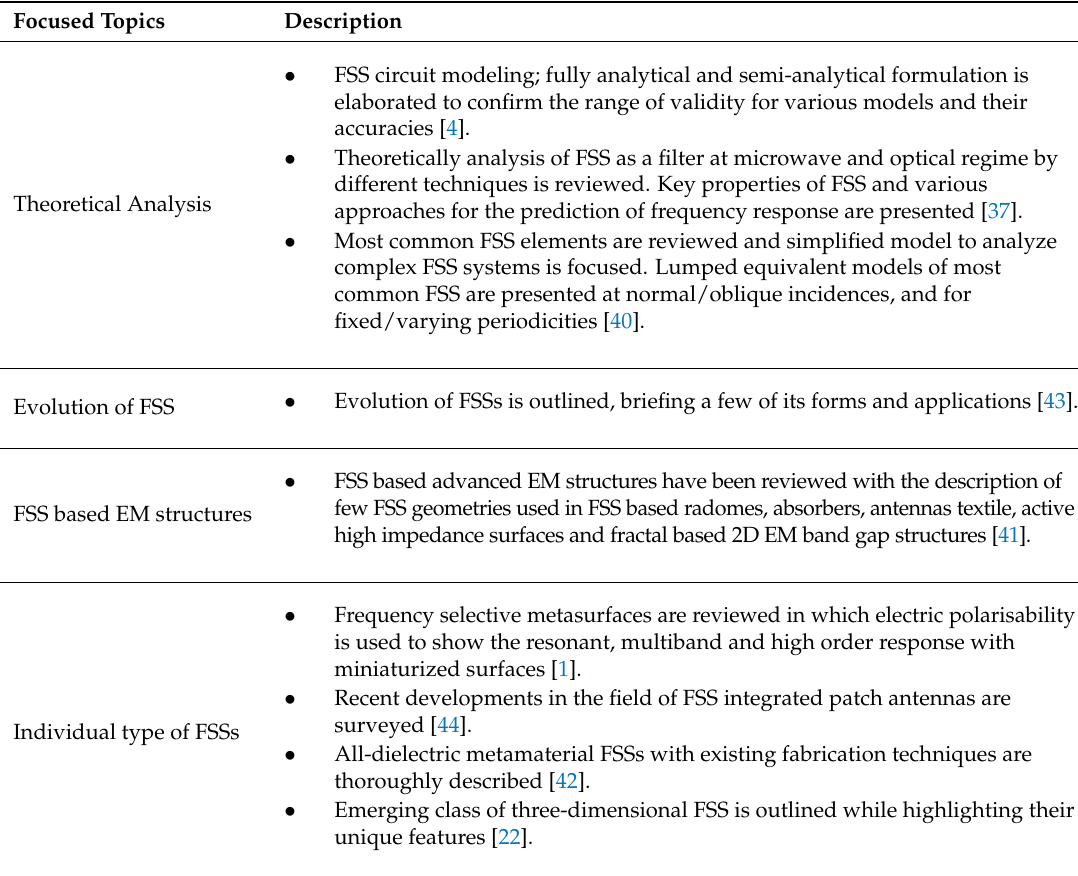
Table 1. Summary of focused topics of frequency selective surfaces (FSSs) covered by existing